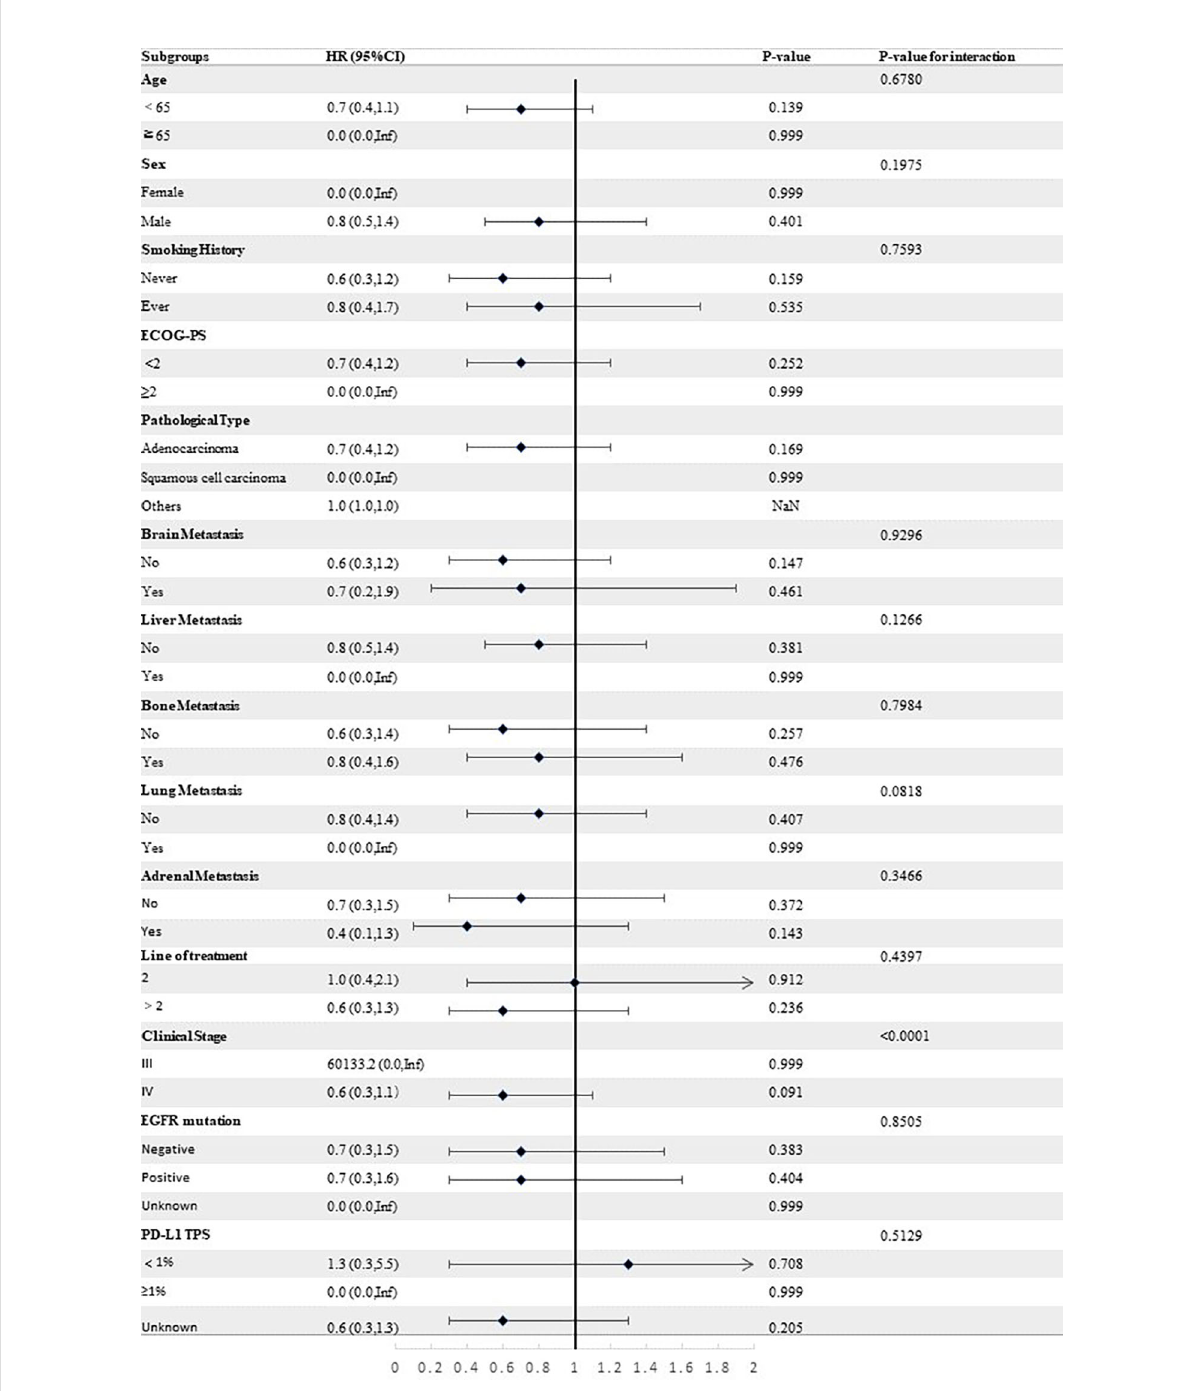
FIGURE 7 Forest plot of risk of death for patients in PAC group compared to PC group in different